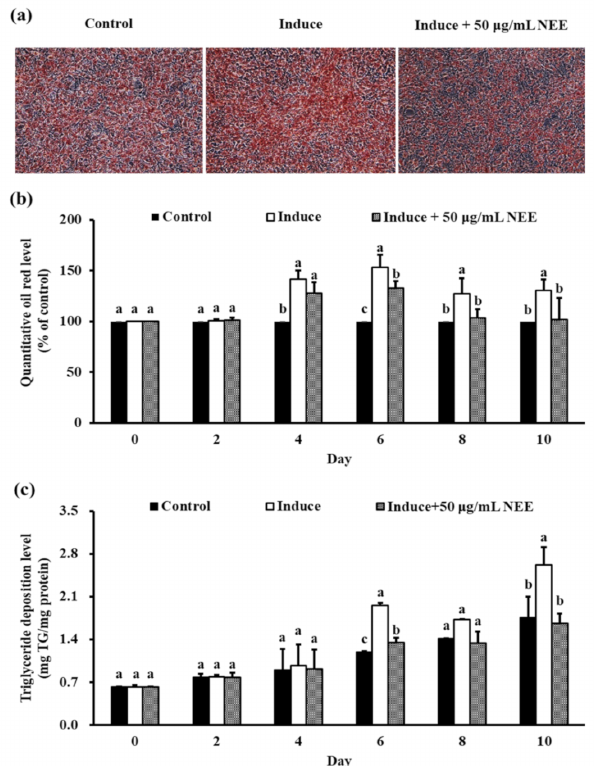
Figure 3. Effects of NEE on lipid accumulation in 3T3-L1 preadipocytes. For 10 days, 3T3-L1 adipocytes were treated or not treated with 50 µ g/mL NEE. Cells were harvested every two days. ( a ) Levels of cell lipid accumulation were determined by Oil Red O staining and observation under the microscope (200 × ) picture only shows the last day. ( b ) The quantity of control lipid accumulation in 3T3-L1 preadipocytes (percent). ( c ) TG concentration (mg TG/mg protein). Control cells are undifferentiated cells. Duncan’s test was used to determine the significance of the variation in cell proliferation. Significant differences ( p < 0.05) between the different concentrations of the NEE group are indicated by different letters (a–c)